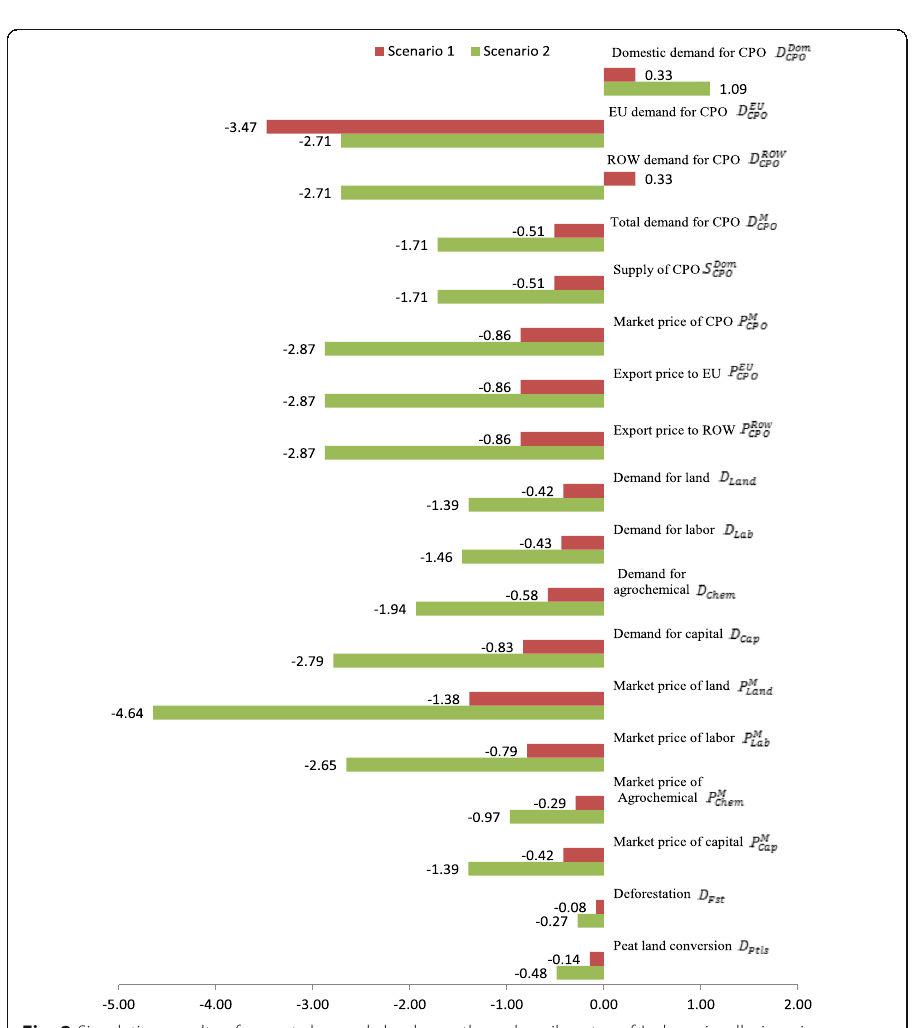
Fig. 2 Simulation results of export demand shocks on the palm oil sector of Indonesia, all given in percentage